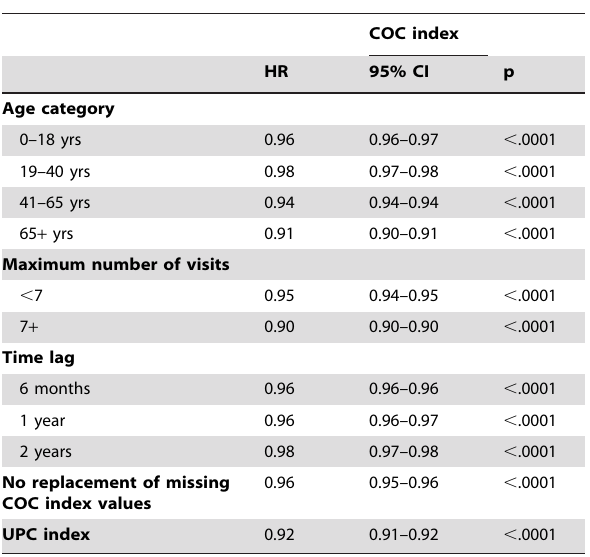
Table 4. Sensitivity